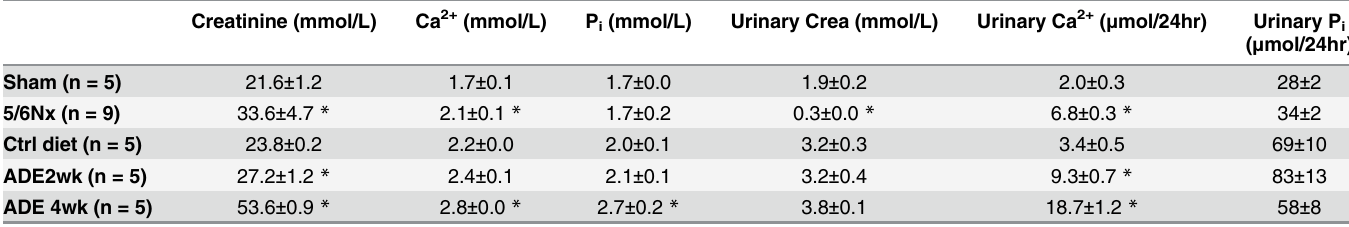
Table 2. The effects of induced CKD on deregulated Ca 2+ and P i